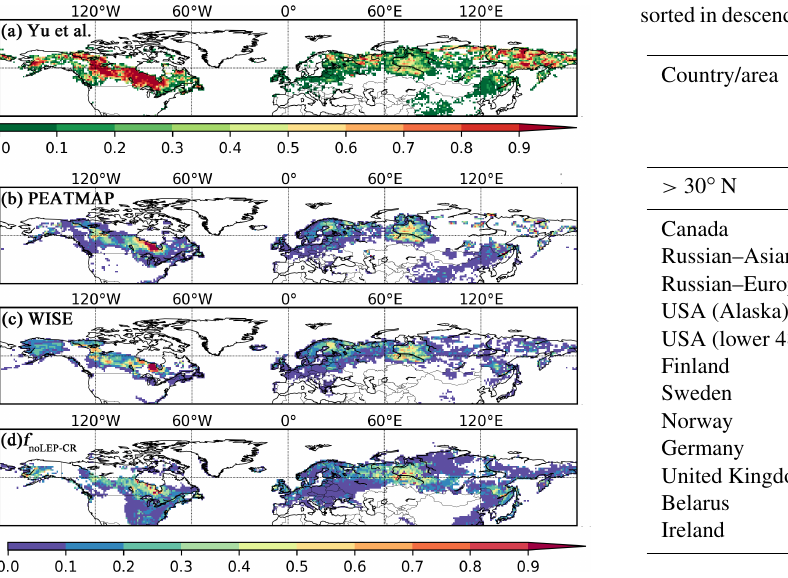
Figure 7. Observed and simulated peatland area fraction. (a) Peat- land fractions obtained from qualitative map of Yu et al. (2010). The original qualitative map only delineates areas with peatland cov- erage greater than 5%; the quantitative data here are derived by aggregating the interpolated 0 . 05 ◦ × 0 . 05 ◦ grid cells into 1 ◦ × 1 ◦ fractions. Thus it is not directly comparable to the fractional peat- land area of other datasets and the model output. We illustrate this with a distinct colour key, (b) peatland area fraction derived from the PEATMAP, (c) histosol fractions from the WISE soil database, and (d) simulated peatland area fraction ( f noLEP-CR ); pattern and timing of deglaciation have been considered. Areas dominated by Leptosols have been masked and areas occupied by crops have been excluded, under the assumption that cropland occupied peatland in proportion to grid cell peat fraction.